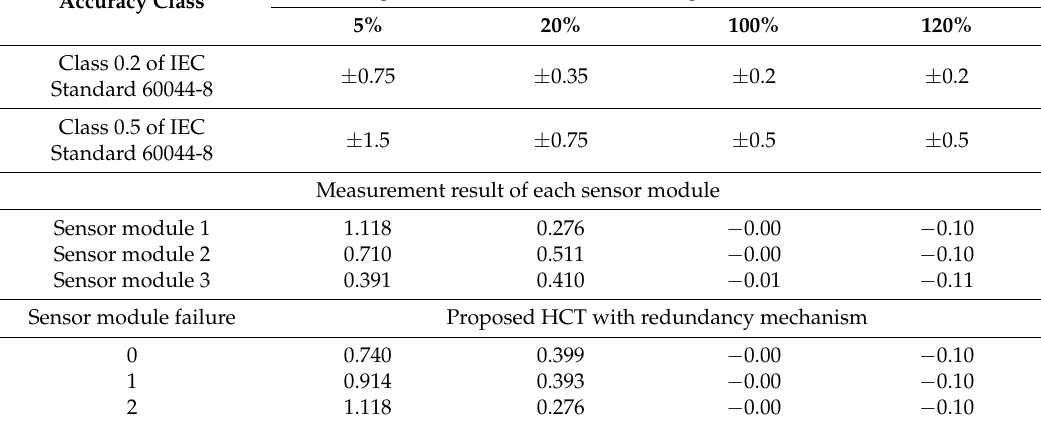
Table 6. Current errors of the proposed HCT when only the R phase is energized to produce testing current.